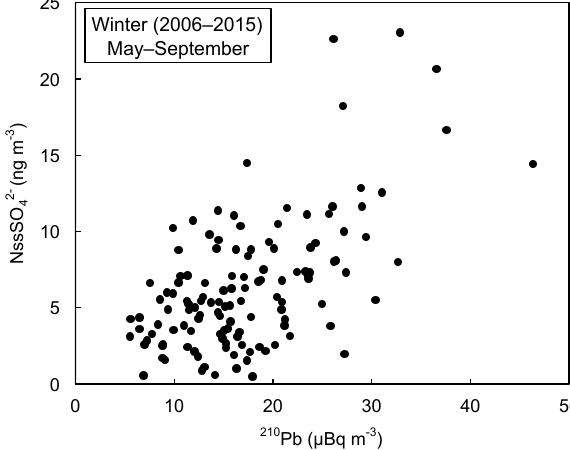
Figure 12. NssSO 4 vs. 210 Pb concentrations on HV filters collected in winter (May–September) at Concordia between 2006 and